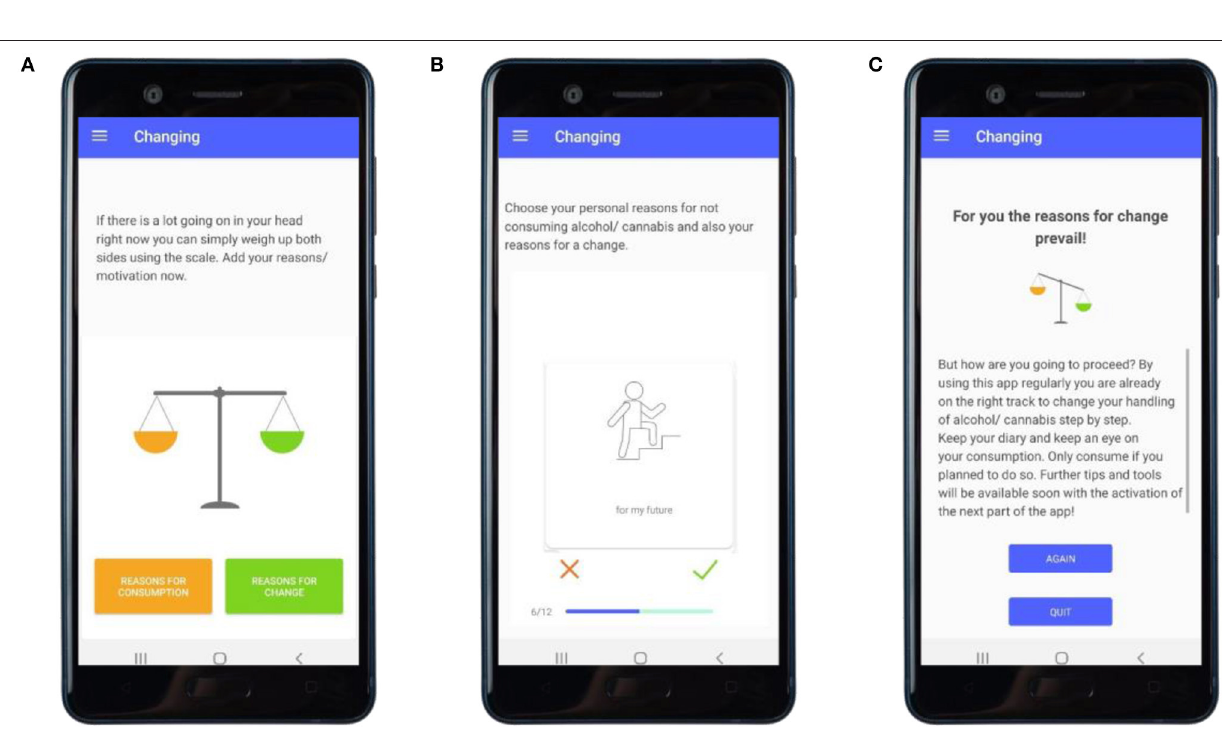
Frontiers in Public Health |